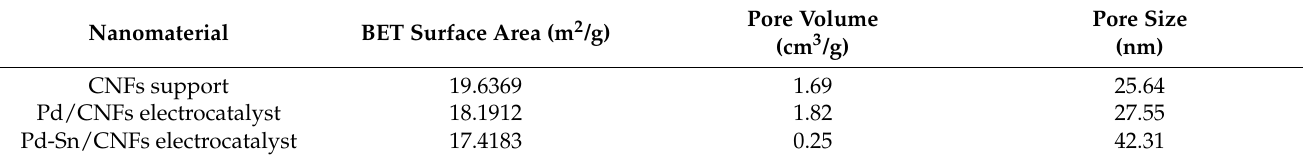
Table 5. BET surface area of CNFs, Pd/CNFs, and Pd-Sn/CNFs.